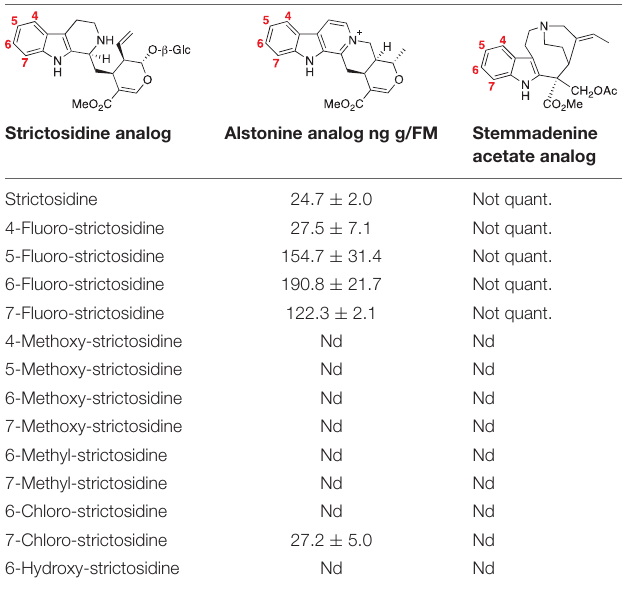
TABLE 1 | Production of alstonine and stemmadenine analogs from strictosidine analogs in N. benthamiana following the co-infiltration of the three genes involved in the alstonine pathway (CrSGD, CrTHAS, CrAS) or the six genes involved in the stemmadenine pathway (CrSGD, CrGS, CrGO, CrReDOX1, CrReDOX2,